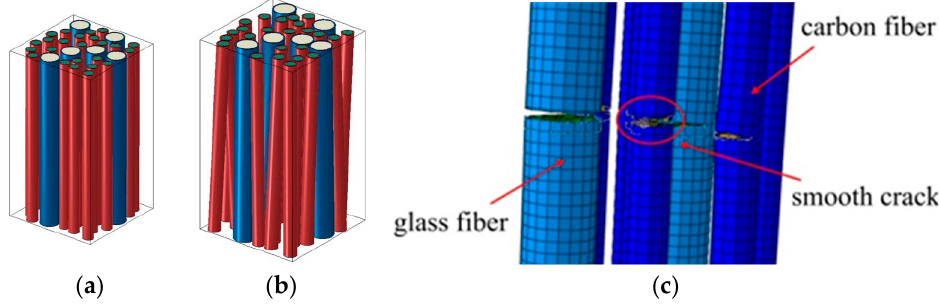
Figure 8. Examples of unit cell FE models of glass/fiber hybrid composites ( a ) aligned; and ( b ) misaligned fibers, and simulated cracking in fibers ( c ) (reprinted from [57] with kind permission from Elsevier). Materials 2017 , 10 , 1278